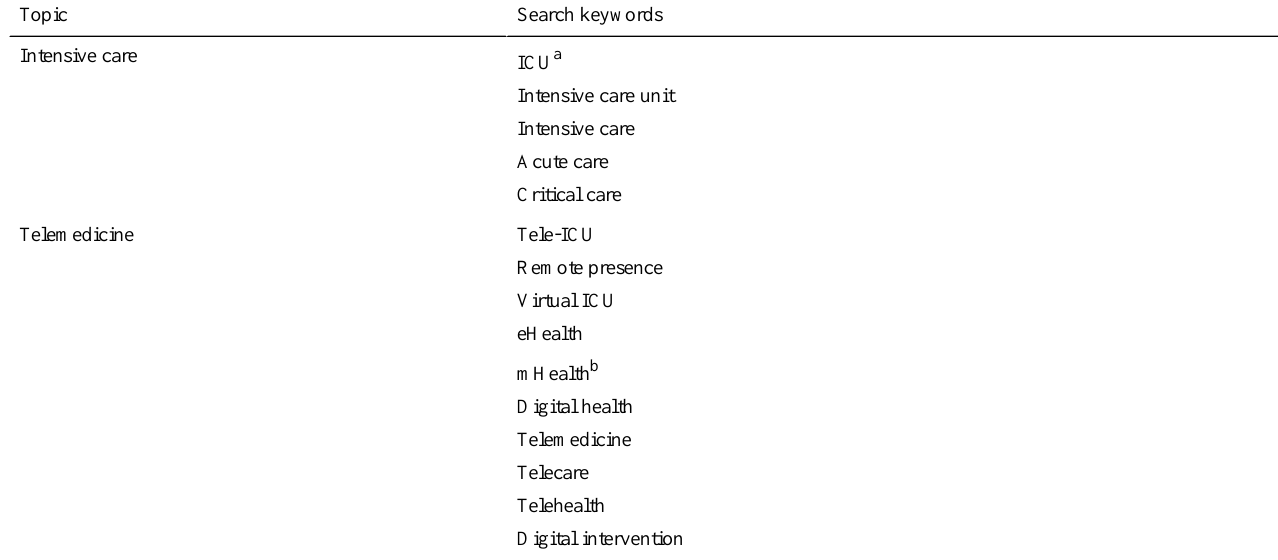
Table 1. Overview of the search terms.